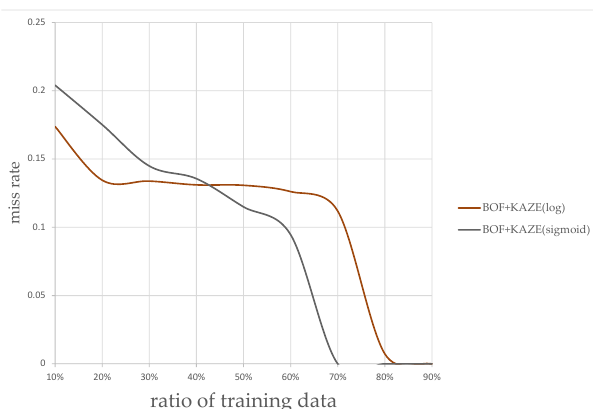
Figure 13. Kaze-based BoF classification rates.